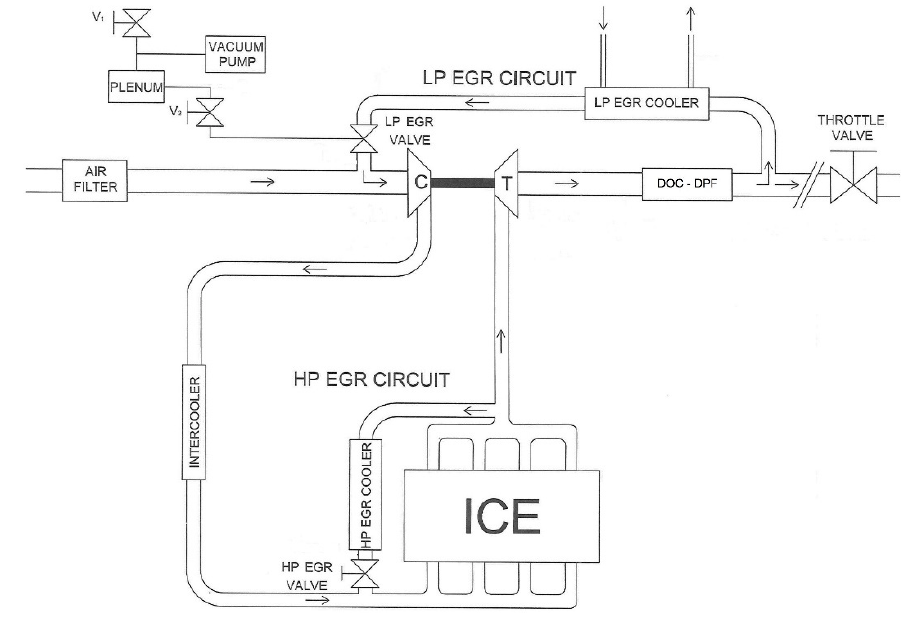
Figure 1. Scheme of tested engine [16].